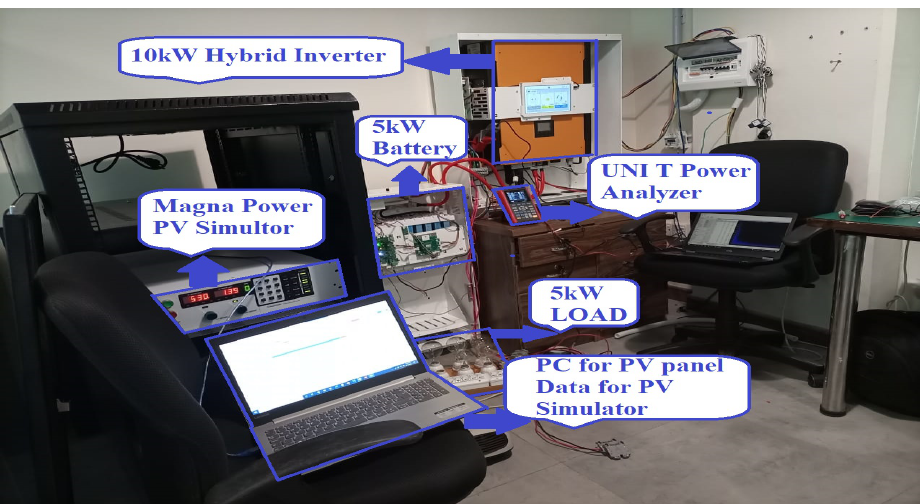
Figure 4. Complete hardware implementation setup.